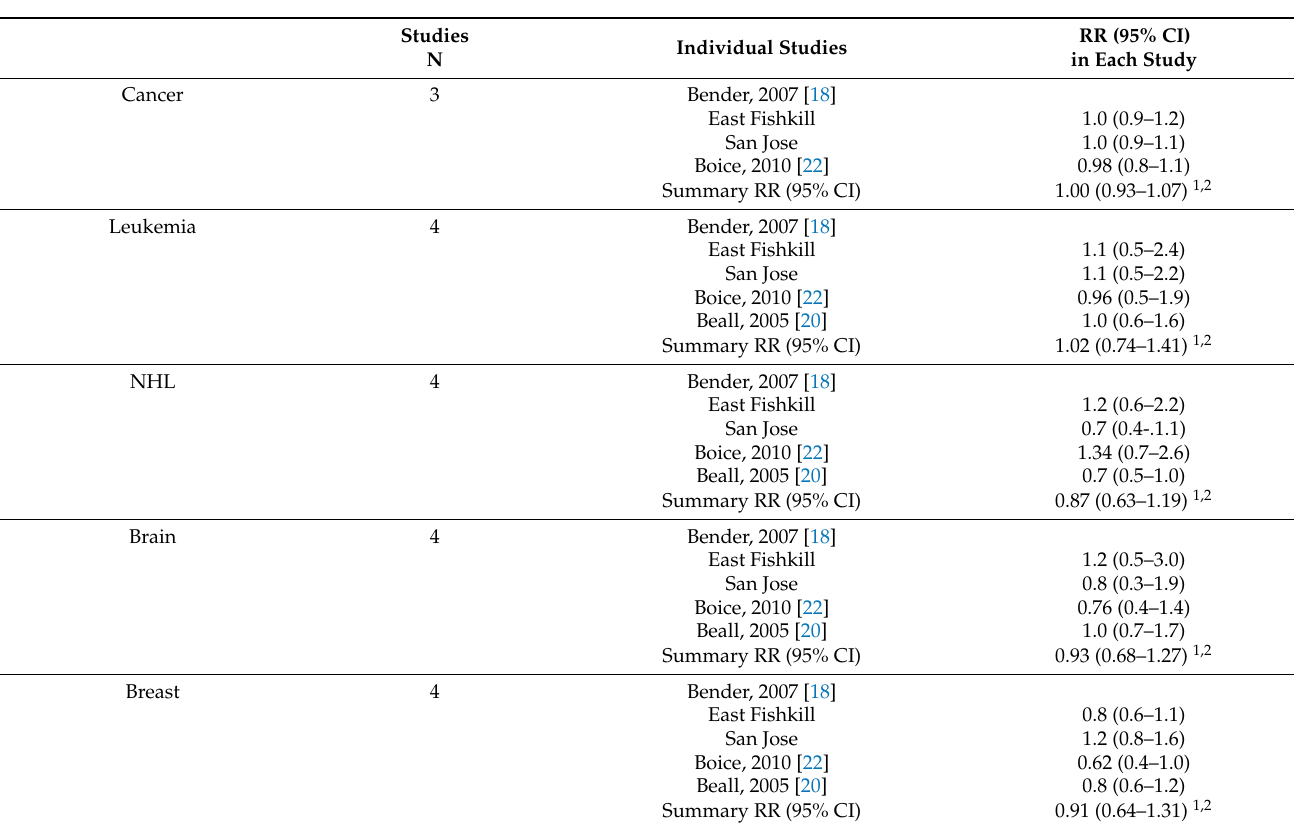
Table 5. Meta-analysis for the relative risks (RRs) of cancer, leukemia, NHL, central nervous system cancers, and breast cancer in exposed semiconductor workers compared to non-exposed semiconduc- tor